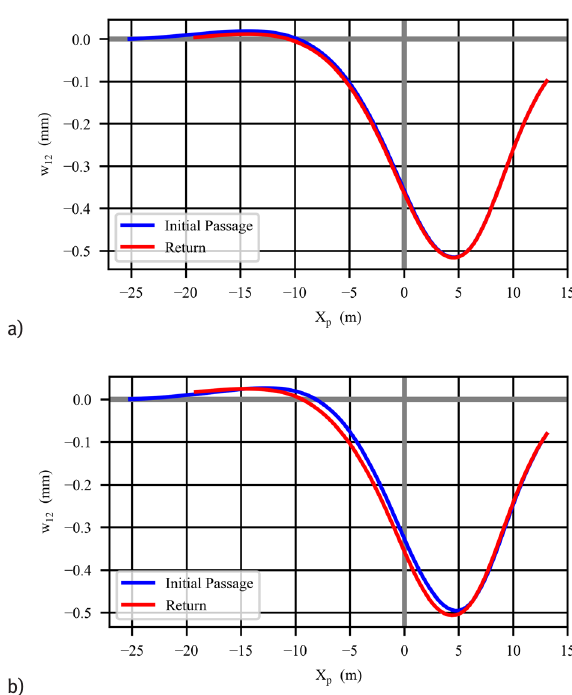
Figure 12: Vertical displacement of point No. 9 during consecutive vehicle crossings: without shell ballasting (a) and with ballasting (b).